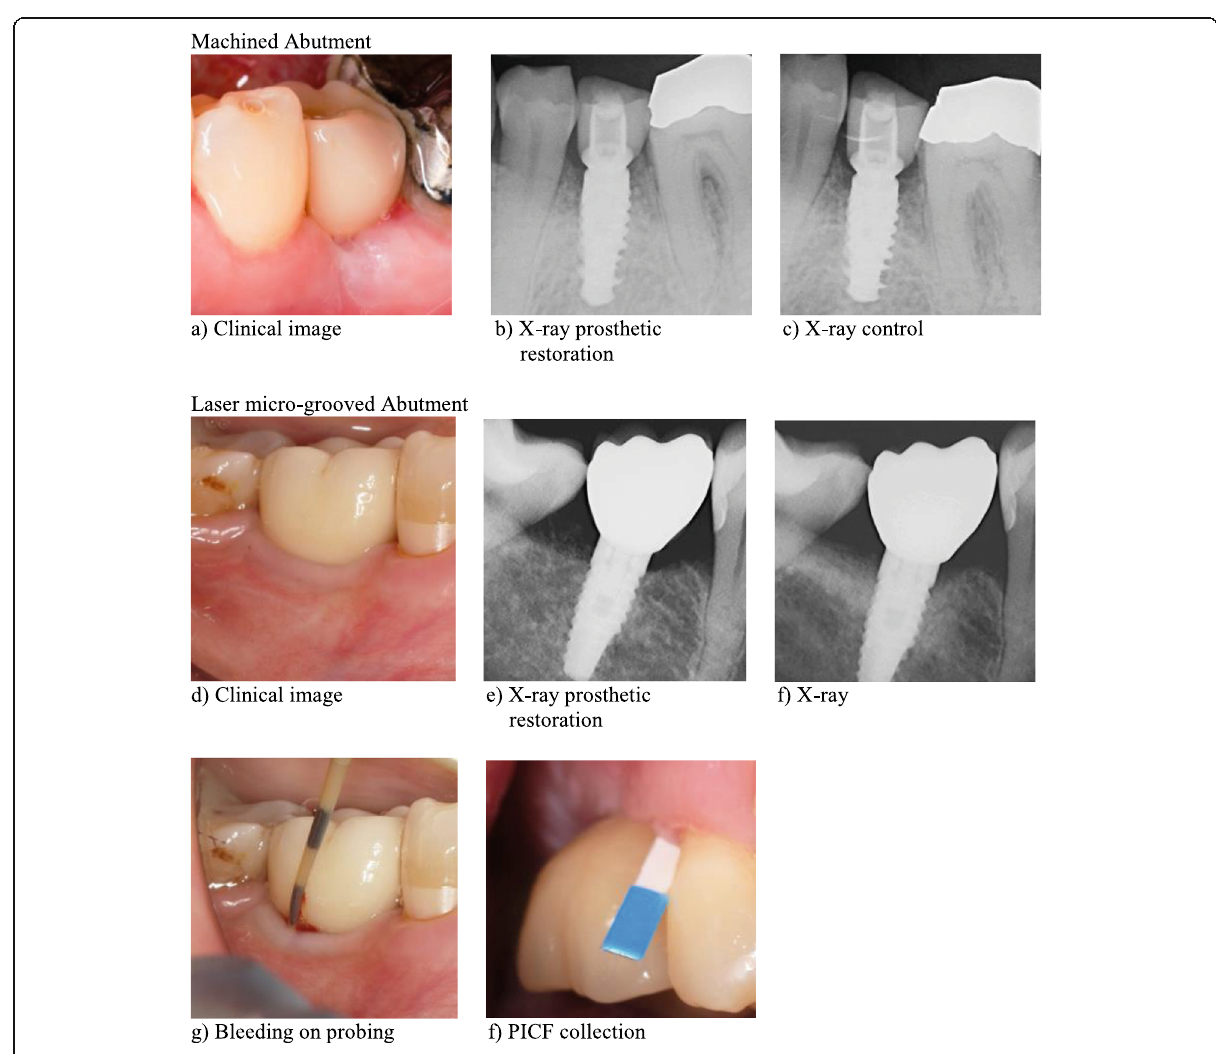
Fig. 1 Clinical and radiographic images. Machined abutment: a clinical image, b X-ray prosthetic, and c X-ray control restoration. Laser microgrooved abutment: d clinical image, e X-ray prosthetic, f X-ray restoration, g bleeding on probing, and f PICF collection